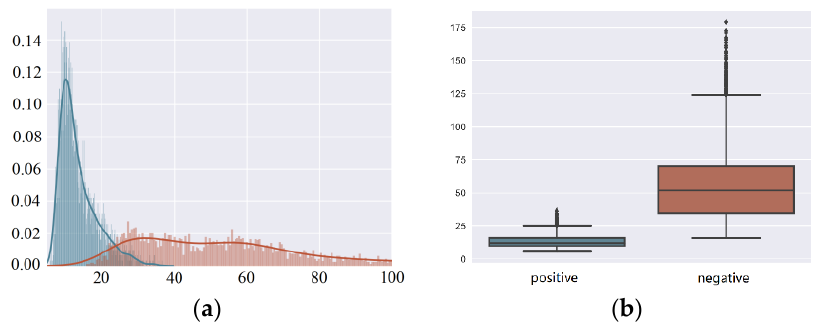
Figure 13. Plots of 𝑀(𝑧, 𝑧̃) of the positive and negative samples. ( a ) Histogram; ( b )